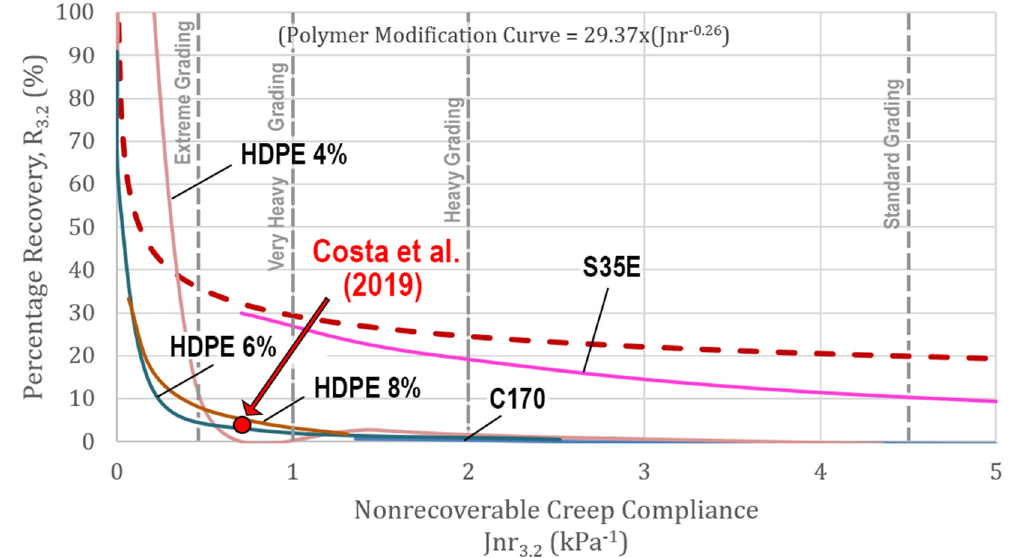
Figure 5. Aged binder indication of elastic response.